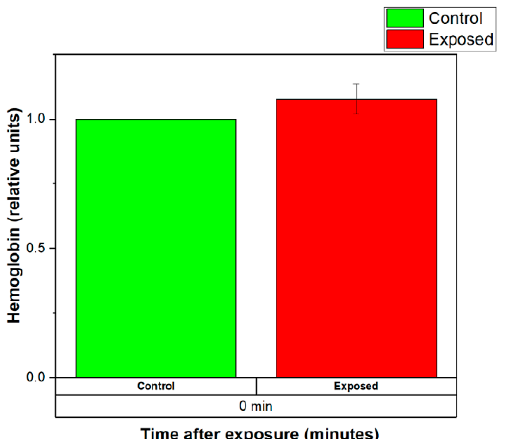
Figure 11. Normalized levels of the hemoglobin released by the control (sham-exposed) and ex- posed erythrocyte suspensions for 20 min to 2.41 GHz (WSA SAR = 29.6325 W/kg, psSAR1g = 41.13 W/kg, wearable antenna input power 450 mW, Zigbee-like signal). The mean of 4 experiments ± SEM is shown.